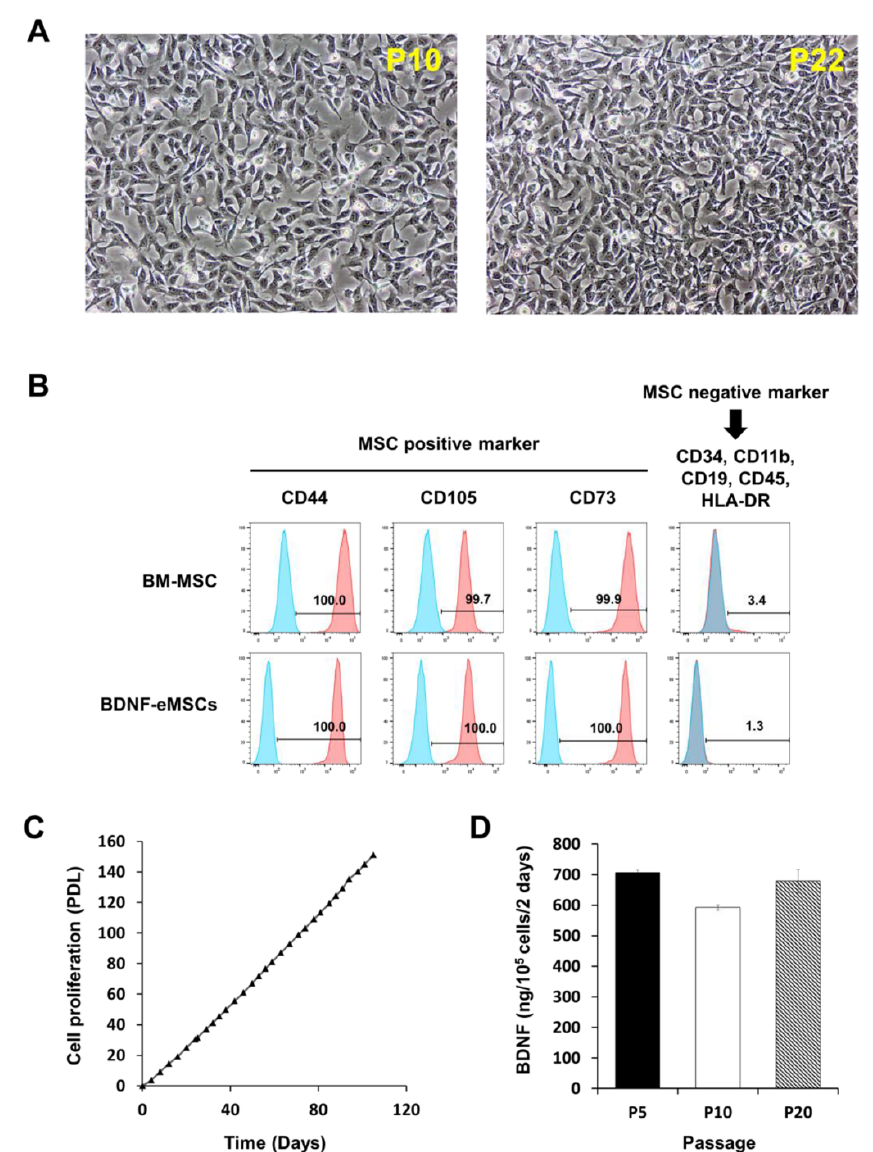
Figure 1. Characterization of BDNF- overexpressing engineered mesenchymal stem cells (eMSCs). ( A ) Morphology of BDNF-eMSCs. ( B ) Flow cytometry analyses show that BDNF-eMSCs express specific markers for MSCs such as CD44, CD105, and CD73. N = three per group ( C ) Cell proliferation rate of BDNF-eMSCs. This result is representative of three independent experiments. ( D ) BDNF secretion of distinct passages of BDNF-eMSCs measured by